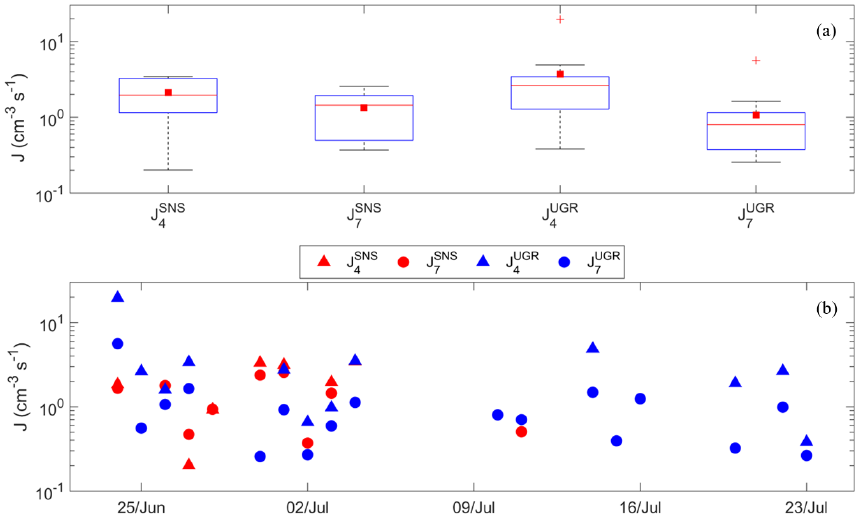
Figure 5. (a) Box and whisker plot of formation rates recorded at the SNS and UGR stations. The red line represents the median of the data, the square represents the mean of the data, and the lower and upper edges of the box represent the 25th and 75th percentiles of the data, respectively. The length of the whiskers represents the 1 . 5 × interquartile range, which includes 99.3% of the data. (b) Formation rate time series at the SNS and UGR